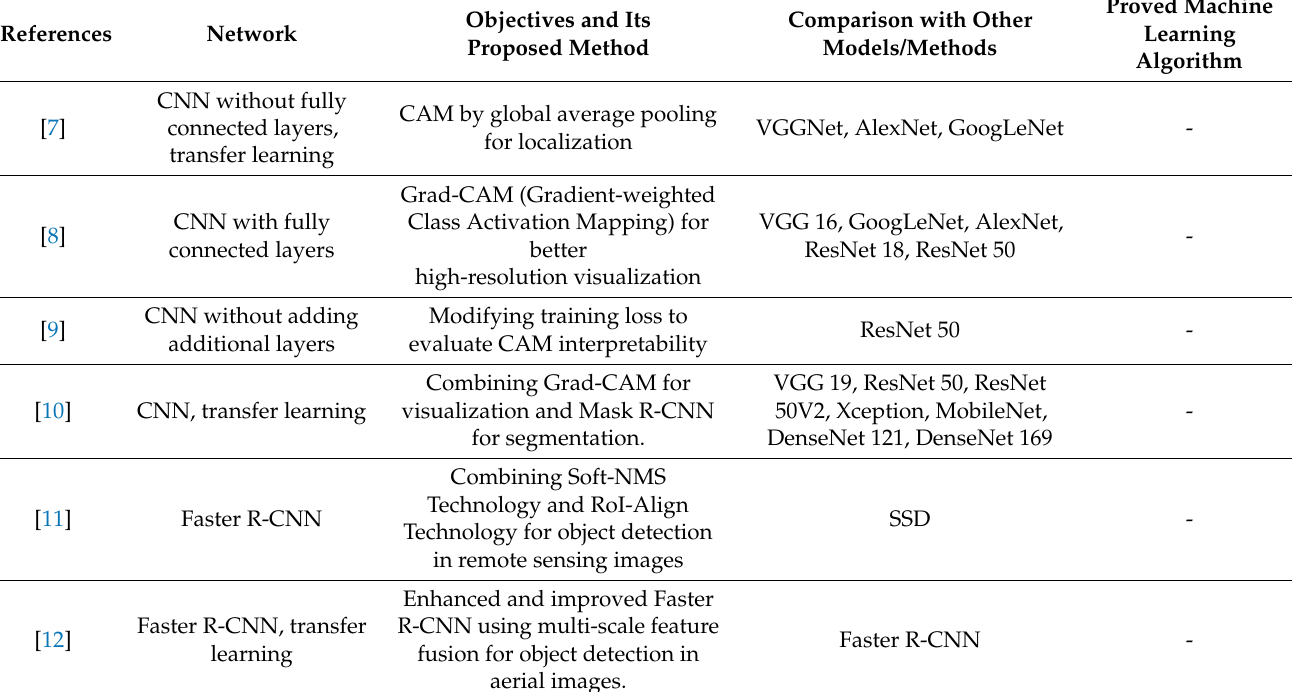
Table 1. A summary of related works for our proposed method